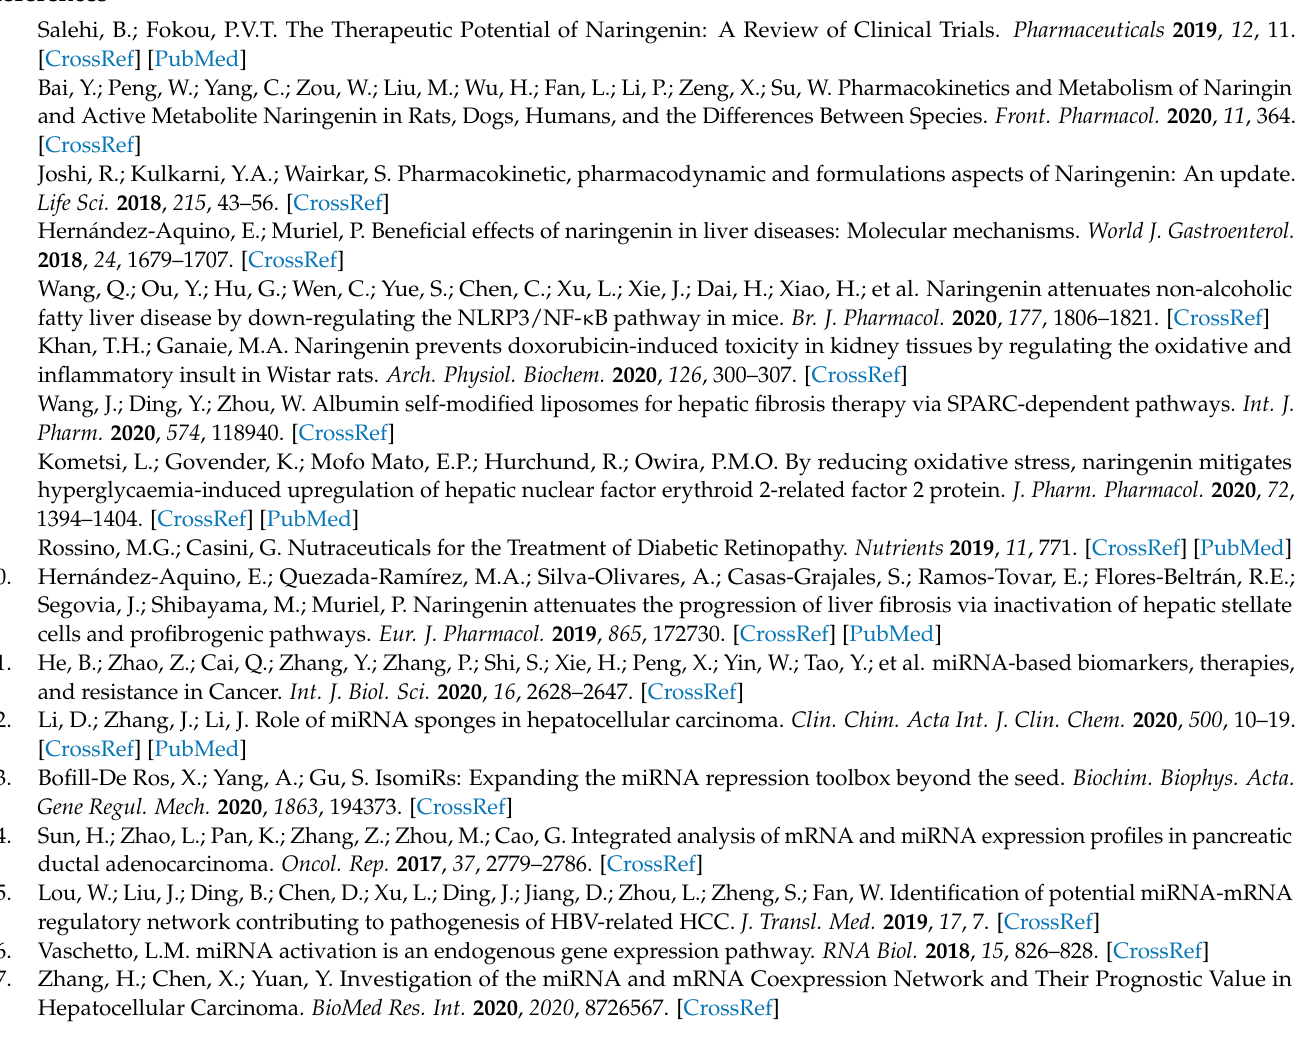
Table S3, Identification of 5607 negative miRNA-mRNA pairs in response to naringenin, with